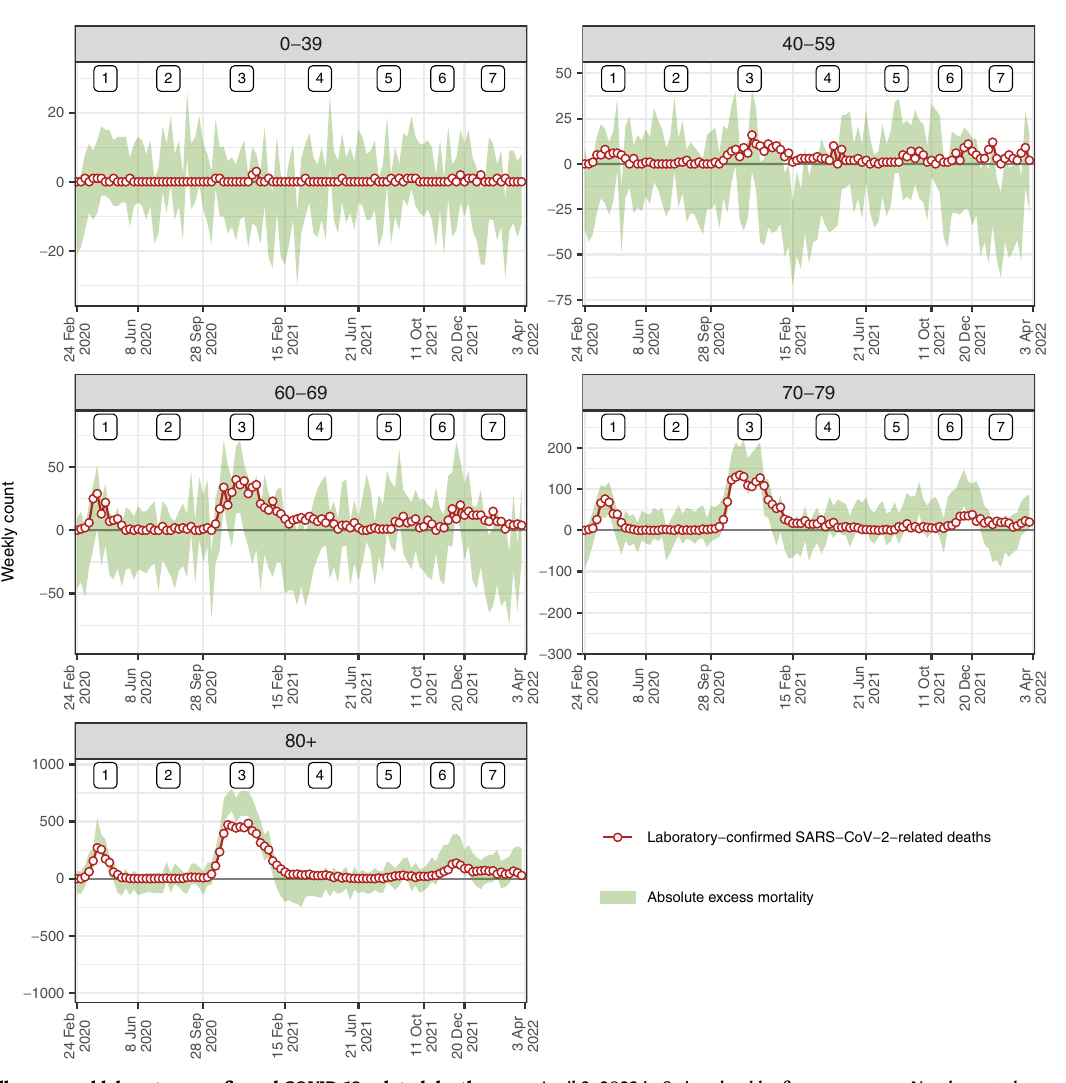
April 3, 2022 in Switzerland by fi ve age groups. Numbers at the top indicate epi- demic phases 1 –